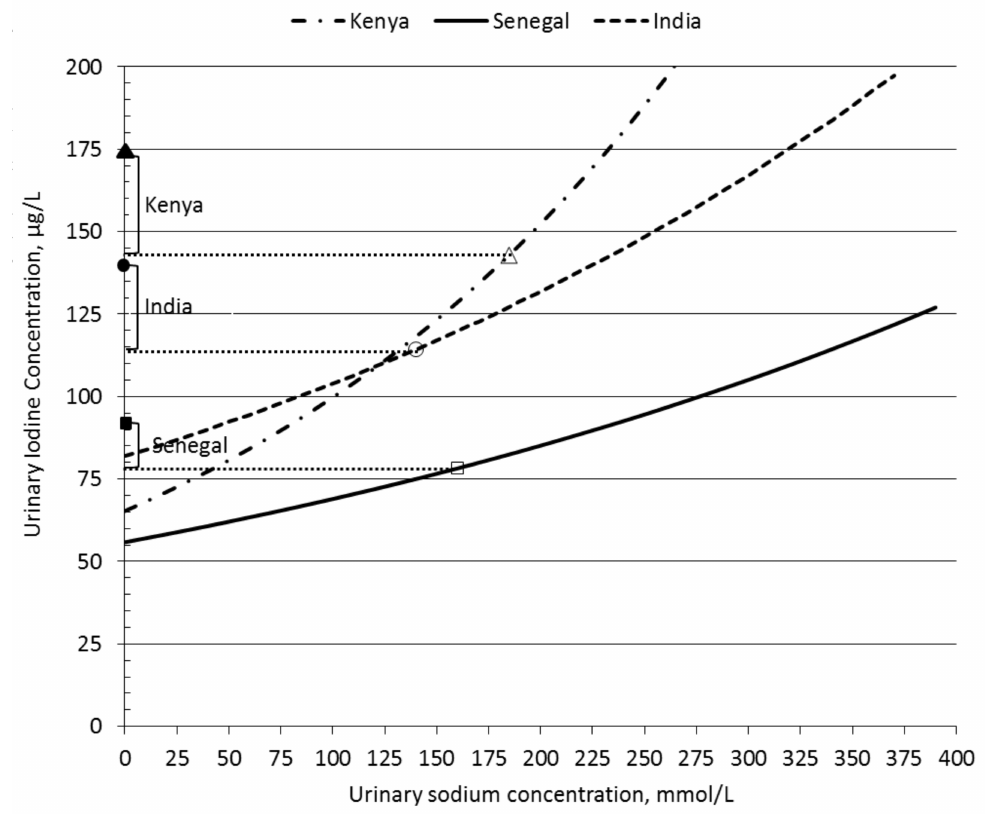
Figure 1. Estimation of UIC portions corresponding with dietary sources of iodine intake of WRA. Marker symbols: Kenya triangles, Senegal squares, India circles. Open symbols indicate the location of average UNaC findings in each country. Their corresponding UIC levels are shown by the horizontal dotted lines. Closed symbols show the total UIC findings and UIC portion estimates attributable to iodine intakes from household salt are illustrated by square